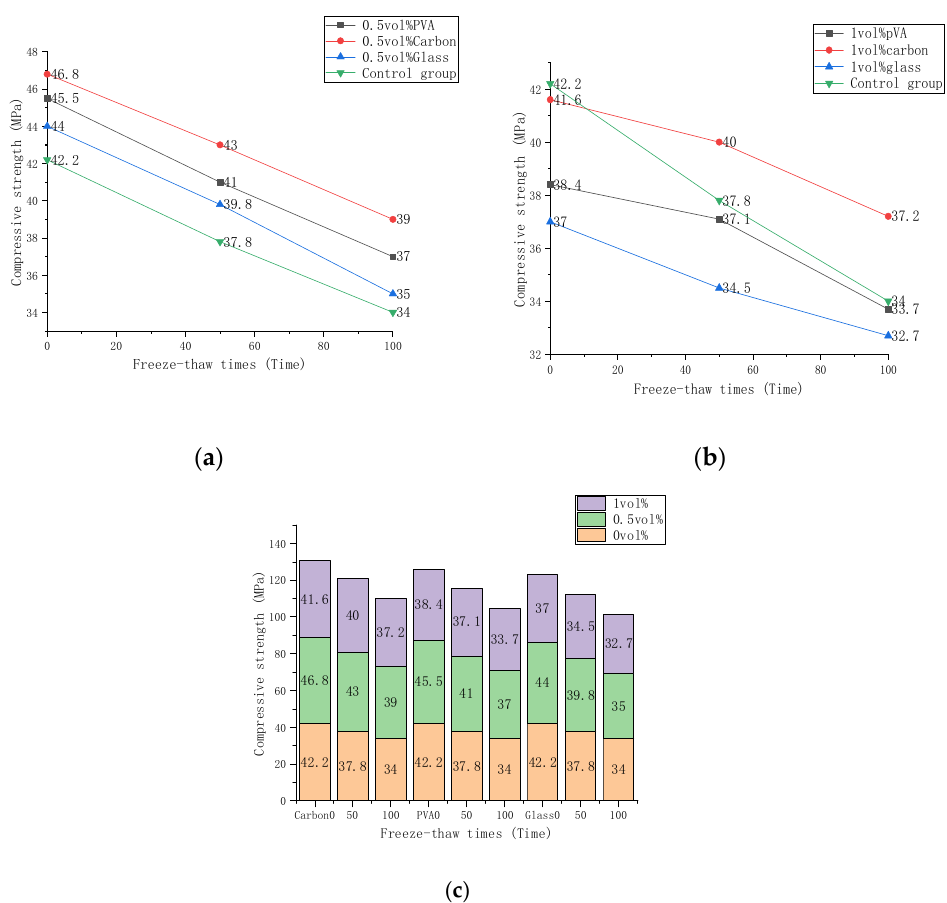
Figure 7. The compressive strength varies with the number of freeze-thaw cycles: ( a ) Compressive strength of 0.5vol%; ( b ) Compressive strength of 1vol%; ( c ) Compressive strength compared with 0vol%, 0.5vol%, 1vol%. Table 5. Compressive strength.